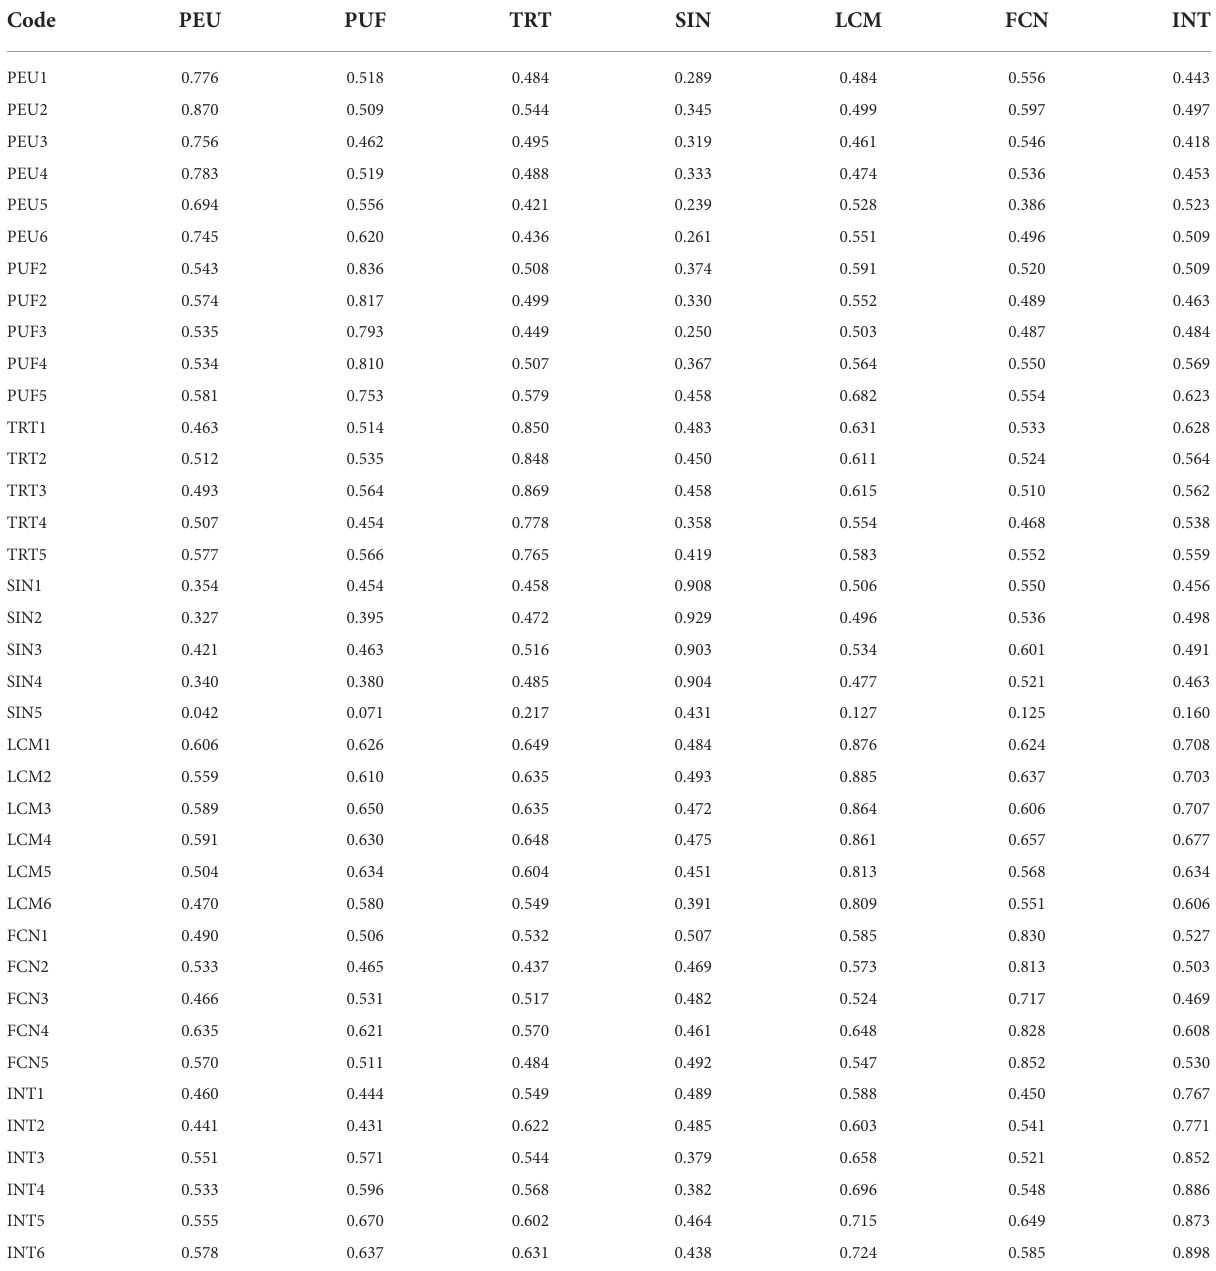
TABLE 5 Loadings and